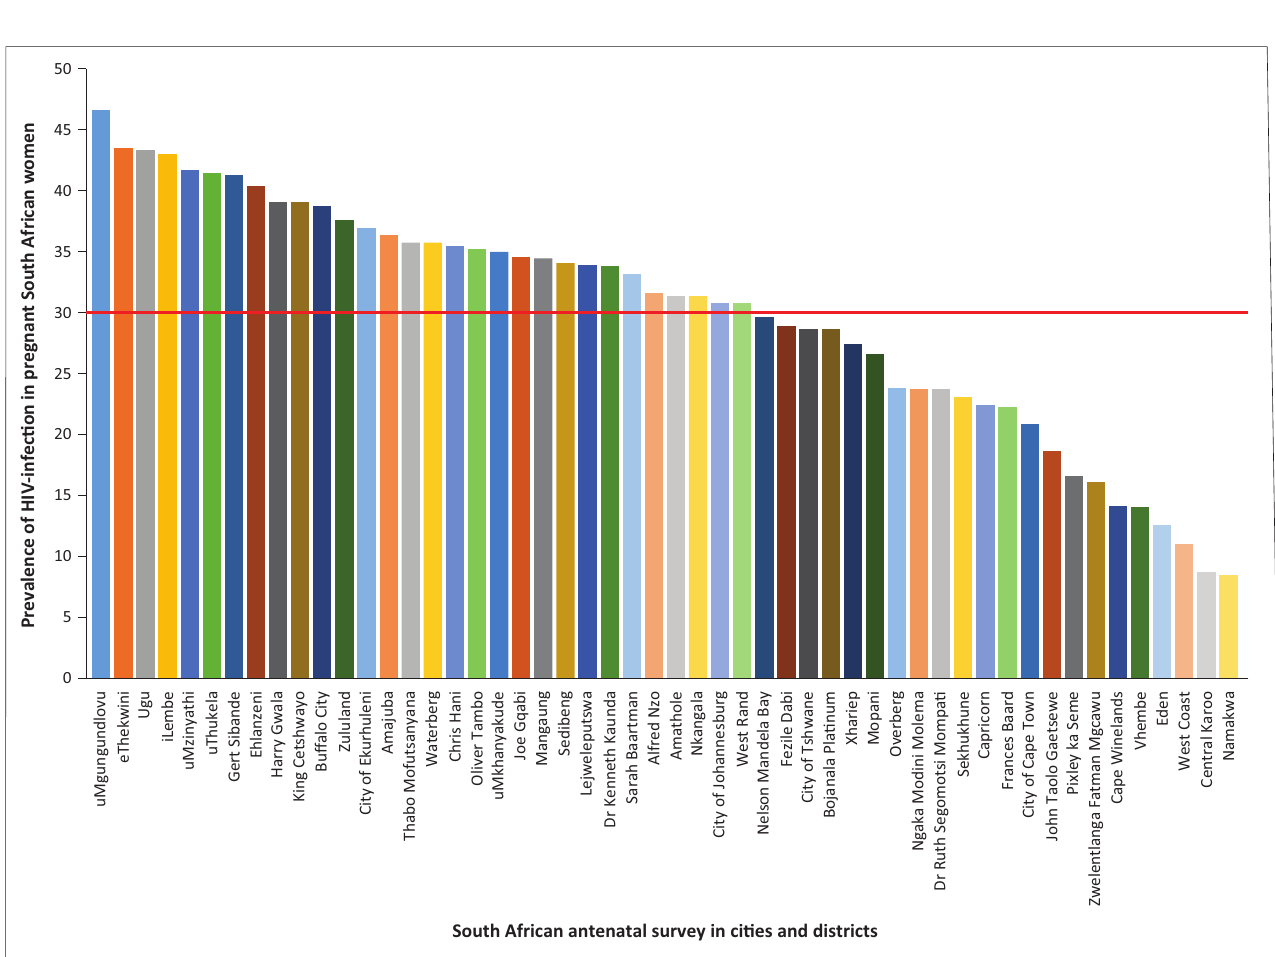
FIGURE 2: The prevalence of HIV among pregnant women by district in South Africa, the South African Antenatal Survey, 2017.